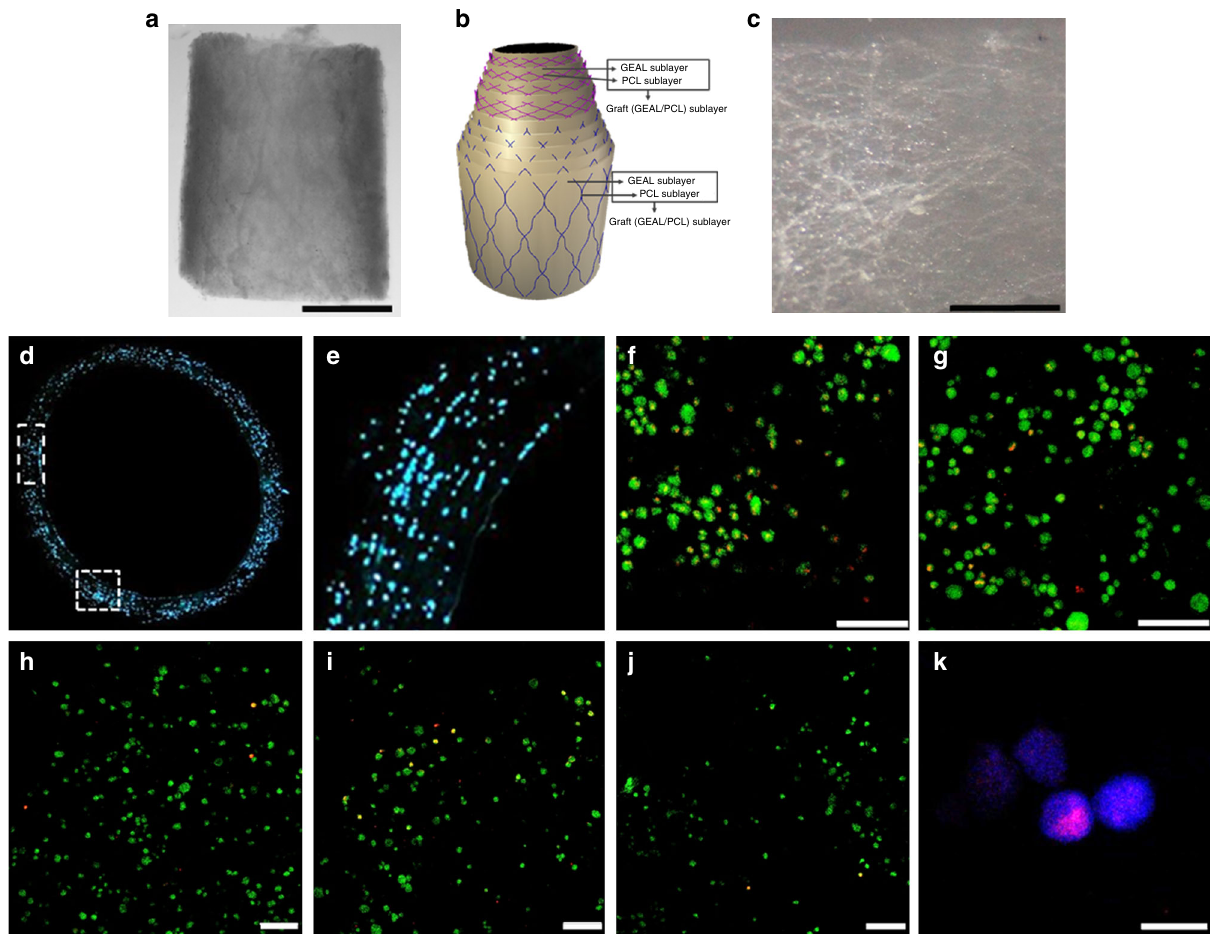
Fig. 7 Density and distribution of cells within the methacryloyl gelatin-alginate (GEAL) sublayers of the fabricated small diameter vascular grafts (SDVGs). a Macroscopic image of a segment of the SDVG (scale bar = 2 mm). b Schematic representation of the SDVG multilayer con fi guration (see also Fig. 1). c A single isolated graft sublayer from a fabricated cellularized SDVG (scale bar = 200 µ m). This particular imaged layer corresponds to a middle graft